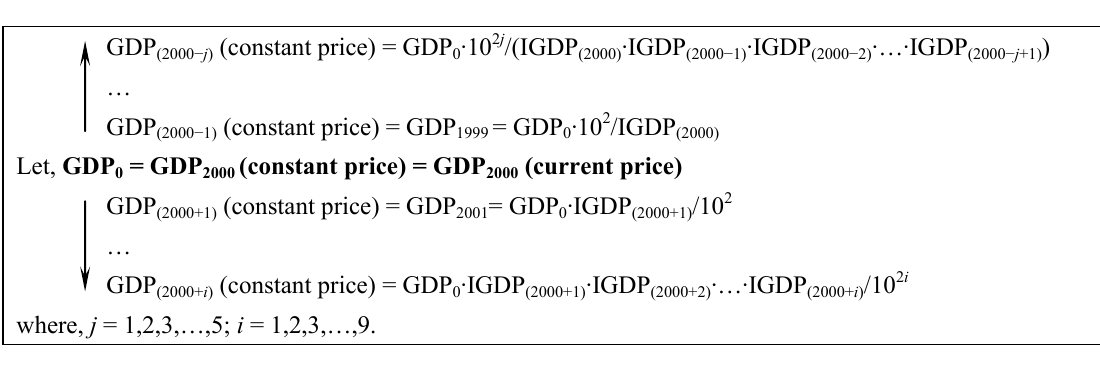
Figure 3. The way to convert the GDP at current price to the GDP at constant price in the year 2000. Notes: IGDP represent Indices of GDP (taking the Indices of GDP for the preceding year = 100), which can be obtained from the official statistical yearbooks